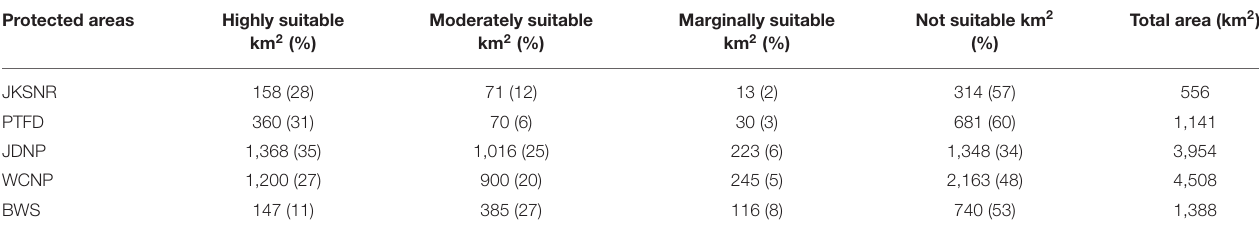
TABLE 2 | Suitable and unsuitable habitats for snow leopards within the protected areas and a territorial forest division (TFD). Protected